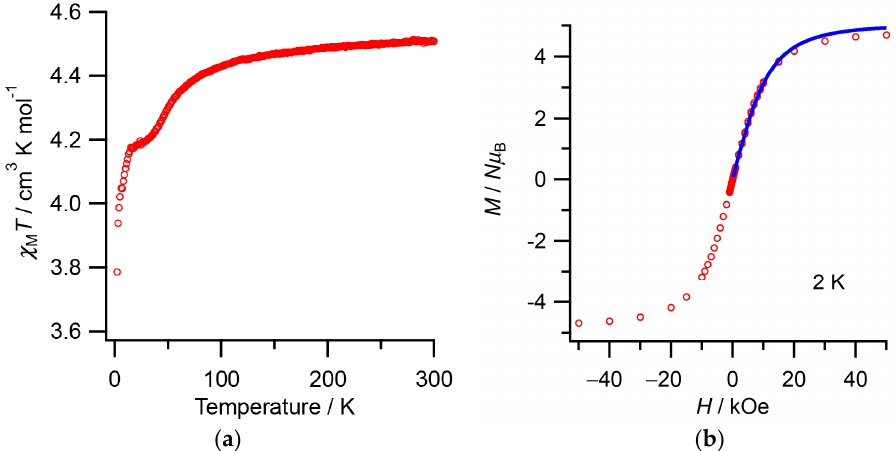
Figure 2. ( a ) χ M T vs. T products for 1 under a magnetic field of 0.5 T at a scan speed of 1 K·min − 1 ; ( b ) Magnetic field dependence of magnetizations for 1 at 2 K. Blue curve indicates the calculated magnetization curve with S = 5/2 and g = 2.